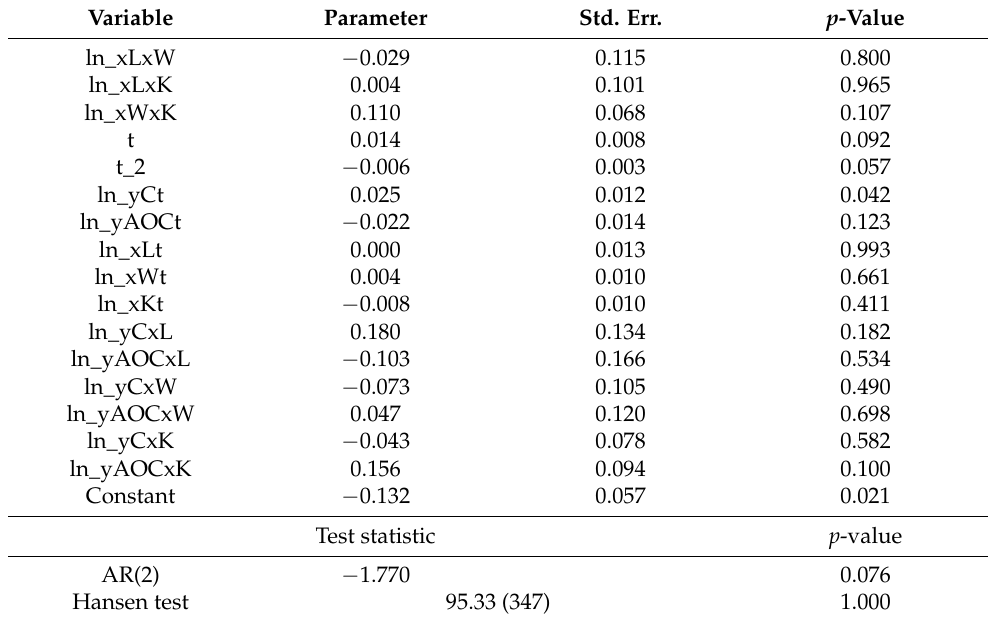
Table A1. Cont . Variable